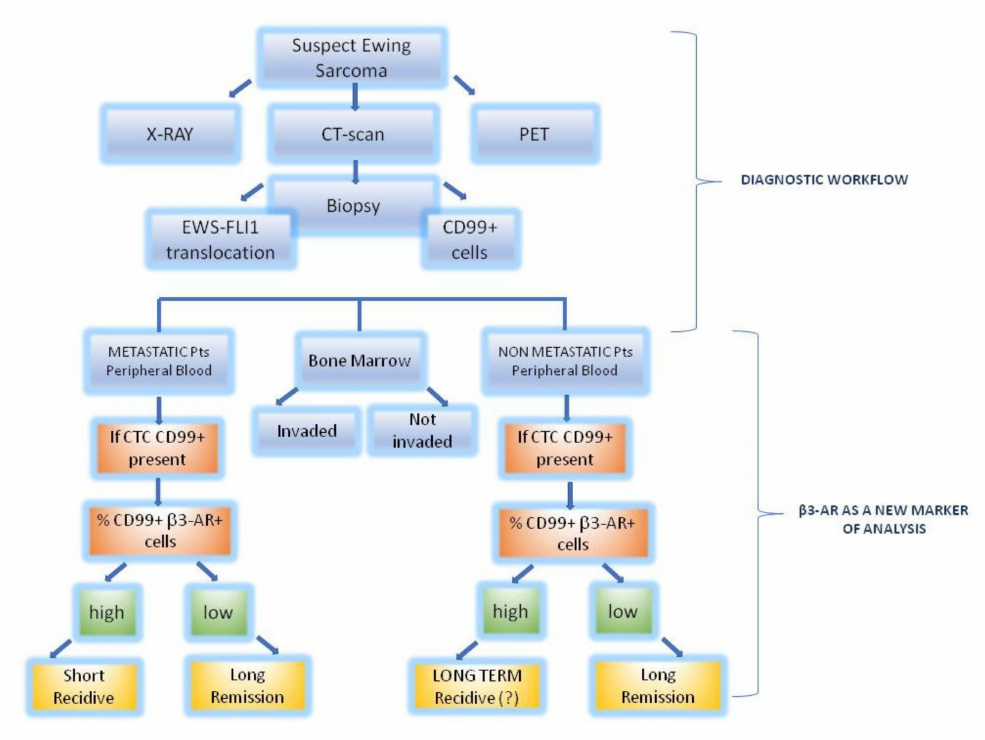
Figure 8. The figure represents in blue squares the routinely workflow for diagnosis and in the coloured squares the new prognostic workflow suggested according to our preliminary